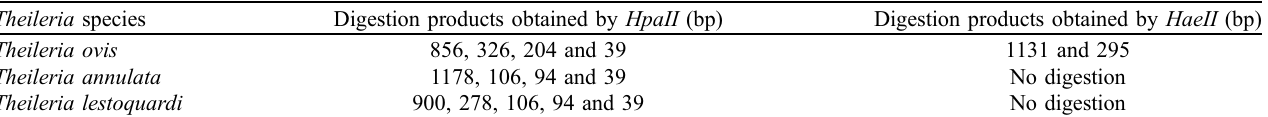
Table 3. RFLP pattern of different Theileria species after HpaII and HaeII digestion (Heidarpour Bami et al. [21]).